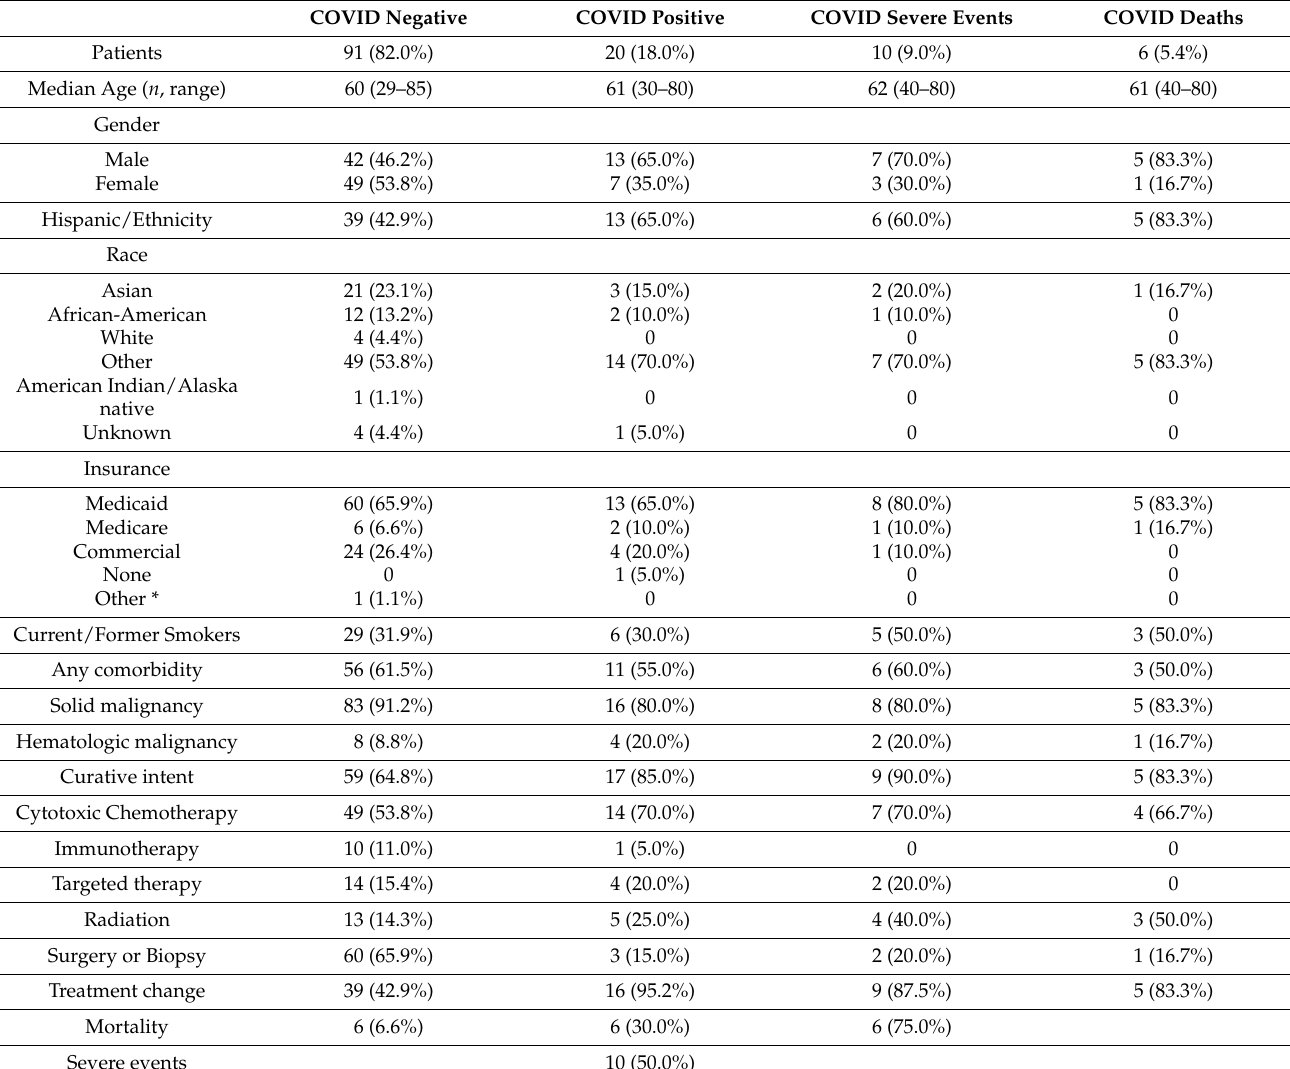
Table 1. Demographics and clinical characteristics in entire